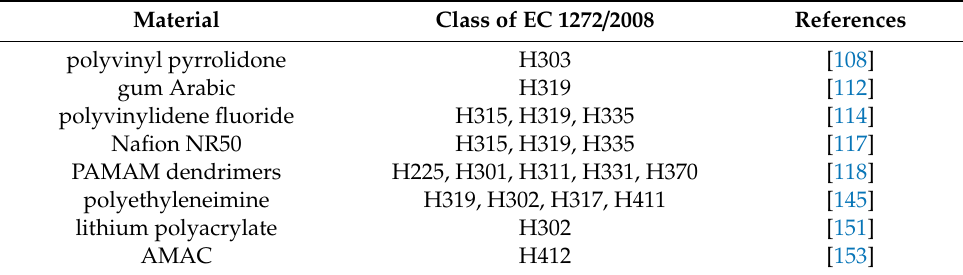
Table 4. Hazard statements of polyvinyl pyrrolidone, gum Arabic, polyvinylidene fluoride, Nafion, PAMAM dendrimers, polyethyleneimine, lithium polyacrylate, and